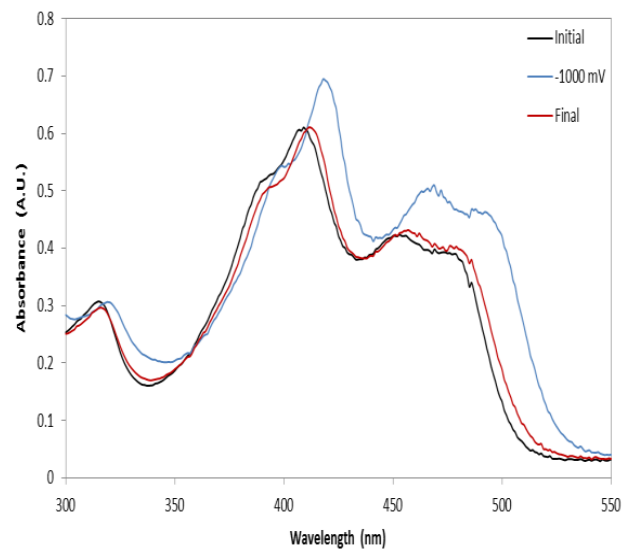
Figure 13 . Absorption spectrum of +2Zn2 hydrazone in acetonitrile as it is reduced at −1.2V and swept back to its initial potential of 0V. The initial and final spectrum, black and red curves, only have slight differences, which is indicative that the complex did not decompose upon reduction at −1.2 V. The complex was tested to examine its stability upon oxidation. In a similar manner, the potential was swept to positive potentials and back to its initial potential of 0.0 V. The complex was oxidized up to + 1.0 V potential and its optical absorption was measured at each potential. All three characteristic absorption peaks of + 2Zn2 hydrazone diminish at approximately + 700 mV, indicative of decomposition of the compound due to electrochemical oxidation of the ligands, as shown in Figure 14. After the potential was swept back to zero, the characteristic peaks did not reappear. This is shown in the final spectrum (purple curve) taken of the complex at 0.0 V after the complex was oxidized at + 1.0 V. These data indicate that the complex cannot undergo a reversible oxidation process. This will limit the electrochemical window of these molecular spacers to below + 0.70 V during electrical energy storage applications.